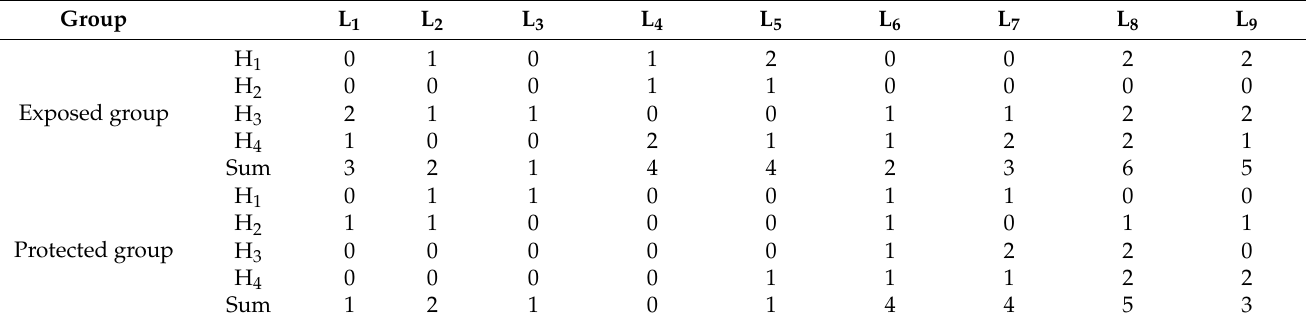
Table 10. Assignment statistics on each measuring line.